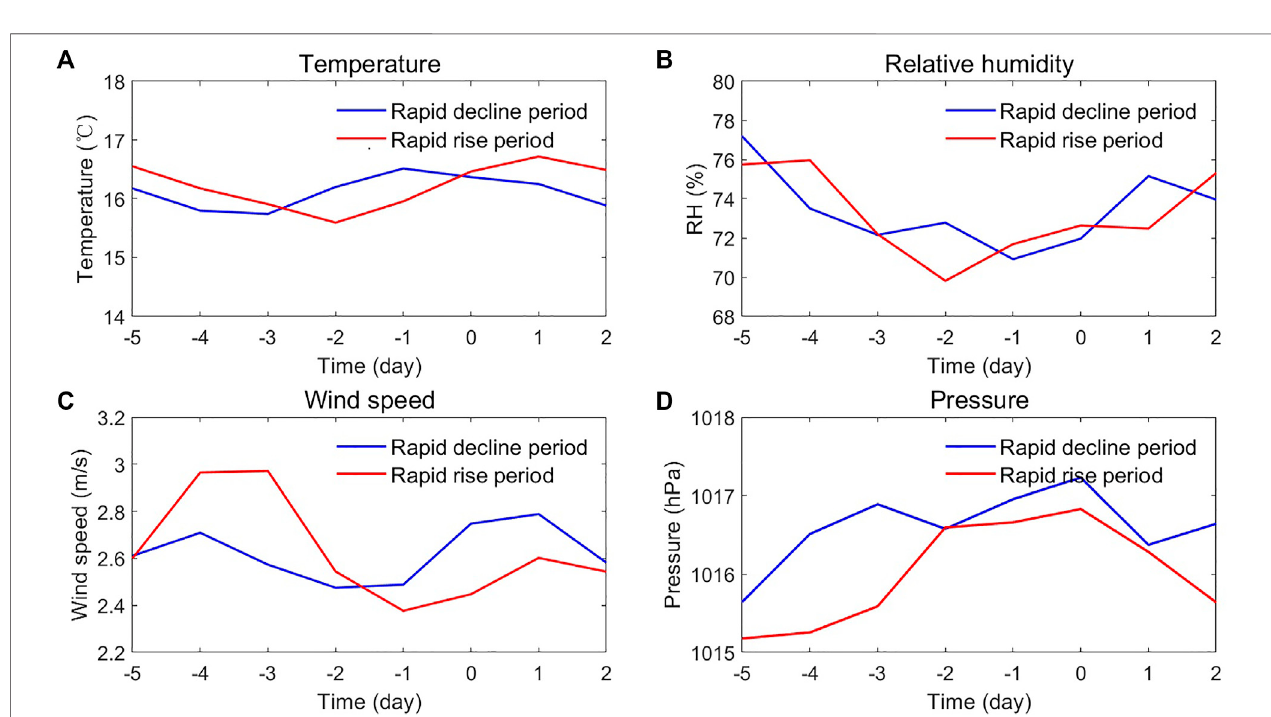
FIGURE 2 | Changes of factors in the atmospheric environment before and after the rapid increases and decreases in PM 2.5 concentration: (A) temperature, (B) relative humidity, (C) wind speed, and (D) atmospheric pressure. (Note: The positive (negative) time indicates the change in environmental meteorological elements occurring before (after) the change in PM 2.5